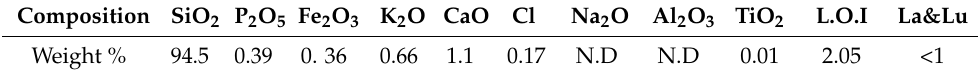
Table 3. Results of XRF